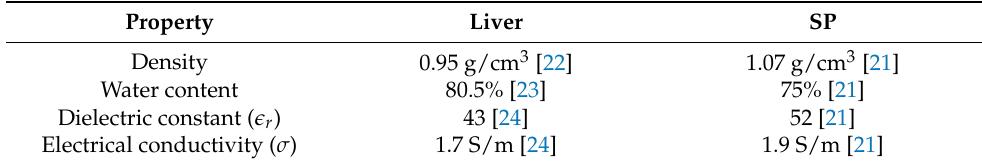
Table 1. Material properties of liver and SP at 2.45 GHz at room